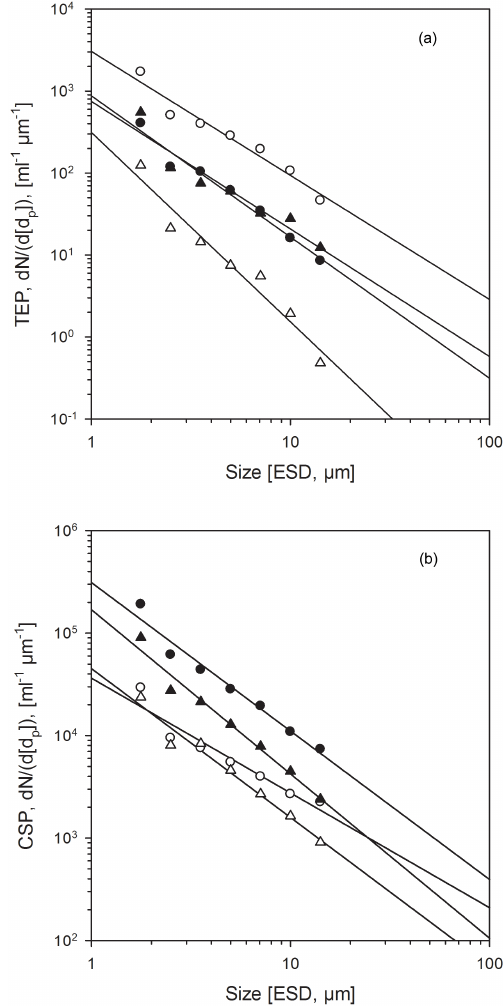
Figure 8. Size–frequency distribution of TEP (a) and CSP (b) ob- served during the M91 cruise for samples collected from the SML (open symbols) and in the ULW (filled symbols) at the stations with lowest wind speed of 0.6ms − 1 (circles) and highest wind speed of 9.0ms − 1 (triangles). Linear regression of log(d N /d( d p )) vs. log( d p ) was fitted to the particles in the size range of 1.05– 14.14µm